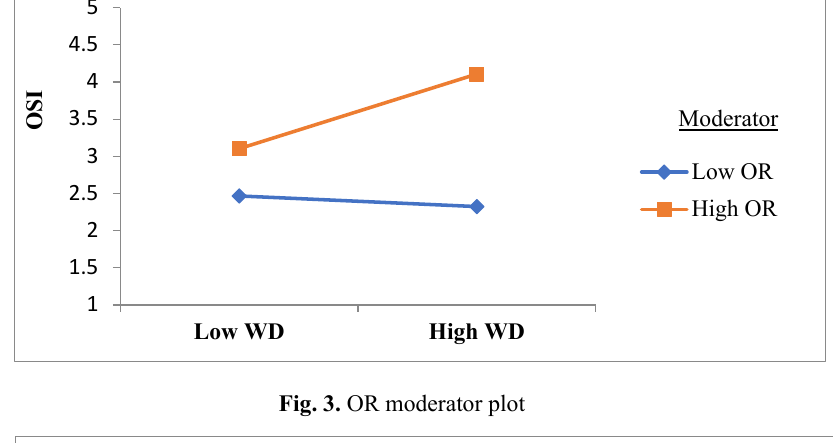
Fig. 3. OR moderator plot